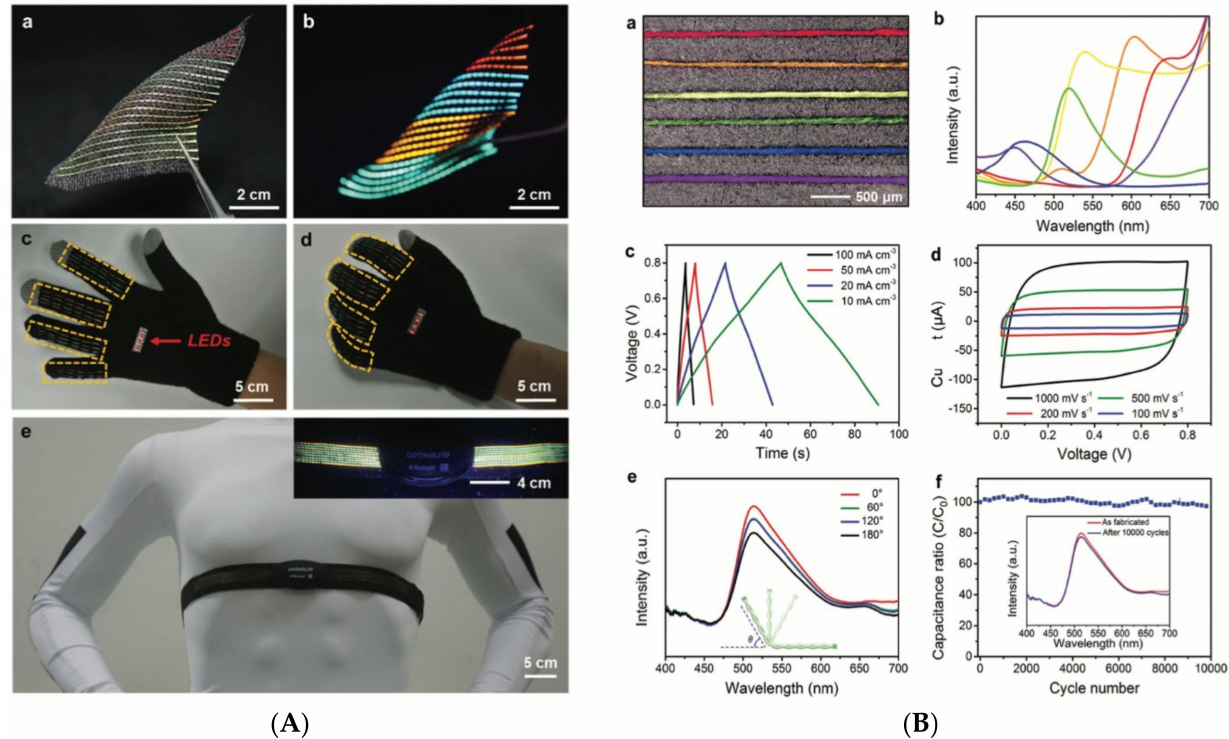
Figure 22. ( A ): ( a , b ) Photographs of twenty fluorescent supercapacitor fibers with four colors woven into a black textile under natural and ultraviolet light, respectively. ( c , d ) Sixteen fluorescent superca- pacitor fibers are divided into four groups and woven into a glove to power four red-light-emitting diodes. ( e ) Eighteen fluorescent supercapacitor fibers integrated into a commercial heart rate moni- toring strap to extend its running time (inset: photograph of the integrated system under ultraviolet illumination). ( B ): ( a , b ) Optical images and spectra of various colored fiber electrodes, ( c ) GCD curves of fluorescent fiber SC based on bare MWCNT at various current densities, ( d ) CV curves at different scan rates, ( e ) spectra of green fluorescent SCs under various bending angles, and ( f ) capacitance retention rates after 10k GCD cycles. (Inset: spectrum before and after 10k GCD cycles). Reproduced with permission from